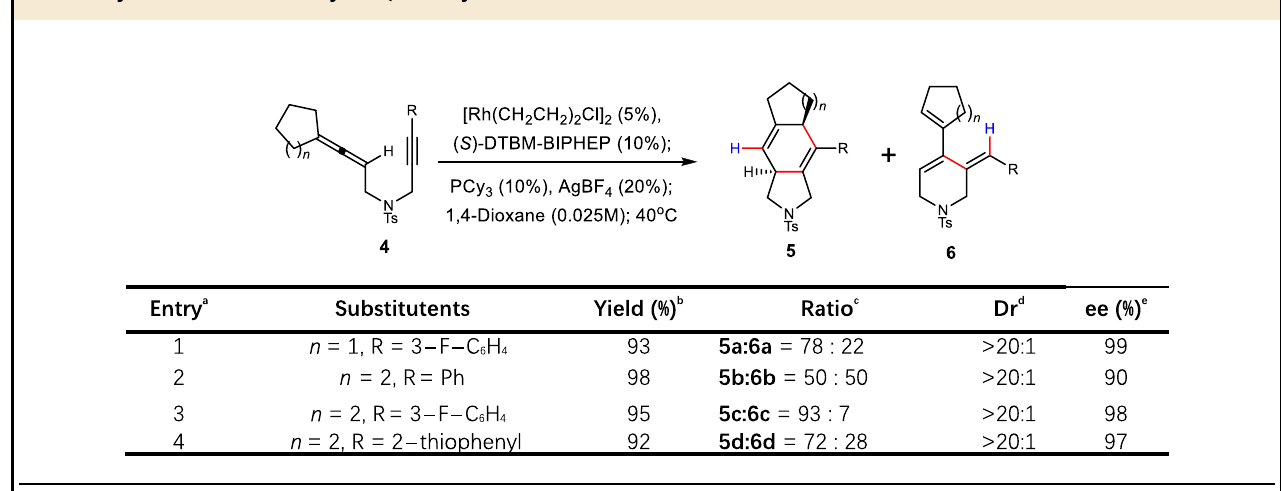
Table 3 Cycloisomerization of cyclic 1,6-allenynes